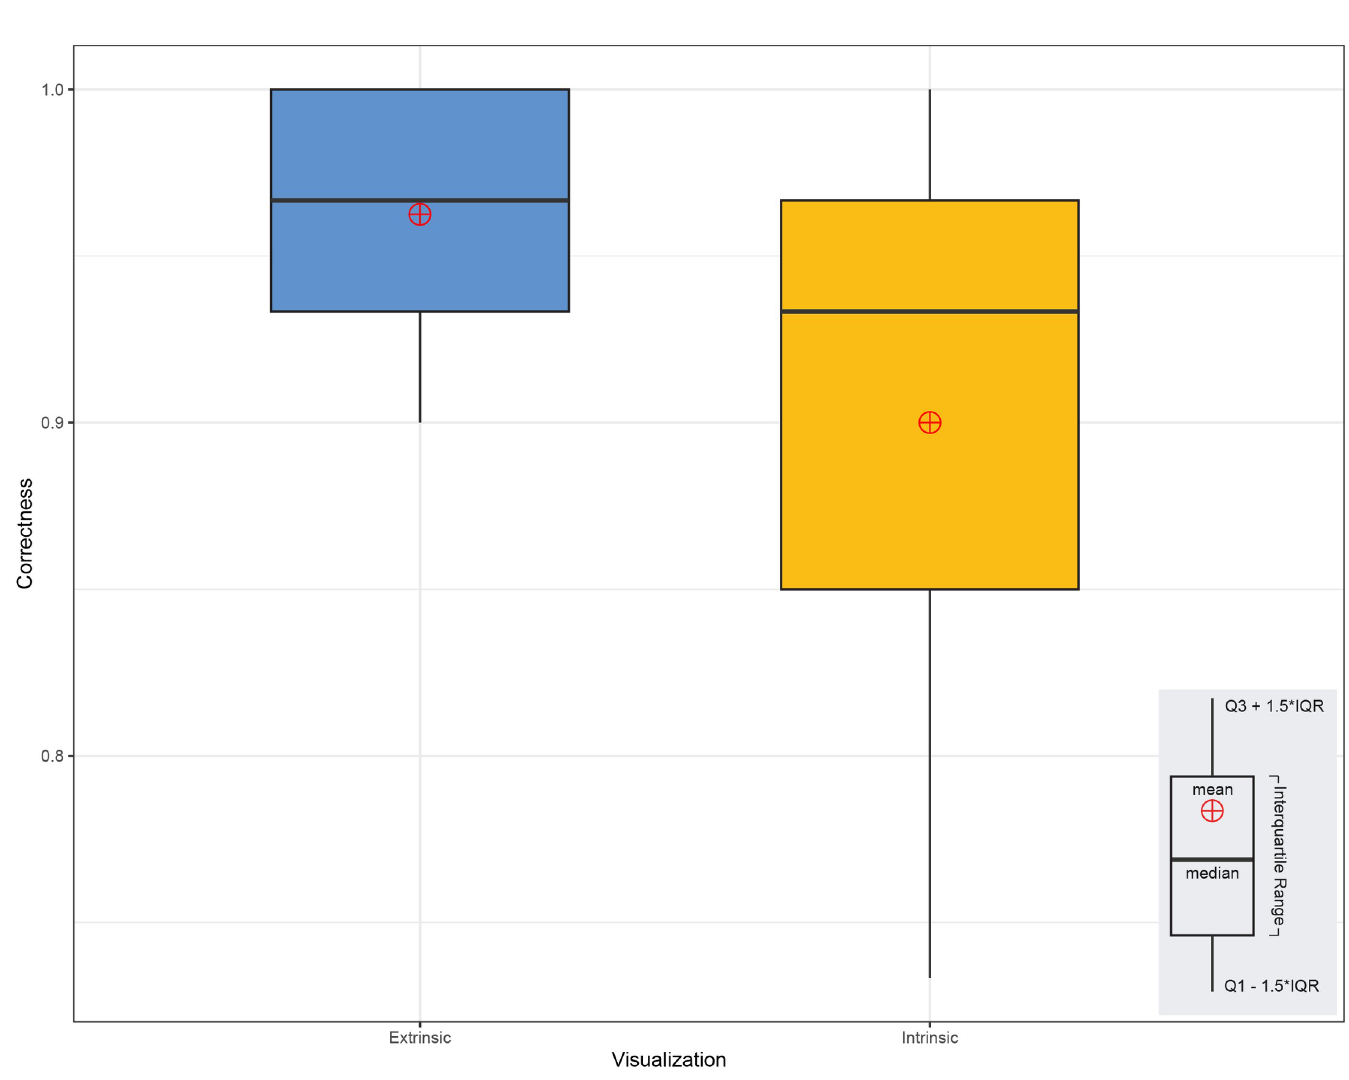
Fig 6. Response correctness for the entire test. Correctness was calculated as a ratio of the number of correct answers to the number of all answers.